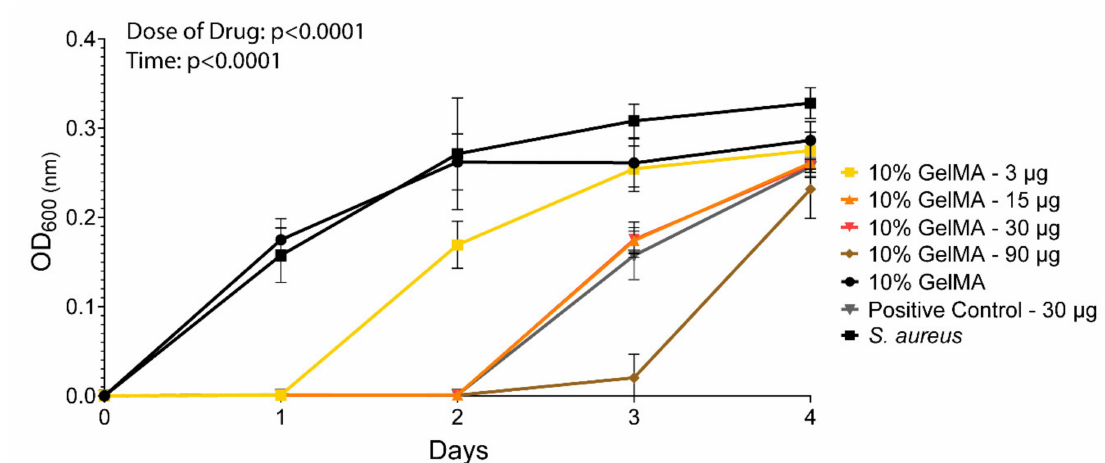
Figure 9. In vitro evaluation of 10% GelMA-DDS efficacy against broth culture of S. aureus . A 0.5 McFarland of S. aureus suspension in MH broth was prepared and diluted 100 times to reach 5 × 10 6 CFU/mL. The broth suspension was added to each well to start the assay (0.5 mL per well), and a new broth solution was prepared every day, at every timepoint except for the last one, to refresh the bacteria solution. Optical density was measured at 600 nm each day for all groups: 3 µ g, 15 µ g, 30 µ g, and 90 µ g cefazolin in 10% GelMA. Control groups were added: 10% GelMA = negative control; S. aureus = negative control; positive control disc containing cefazolin 30 µ g. Data are shown as mean ± SD. The experiment was performed three times with n =